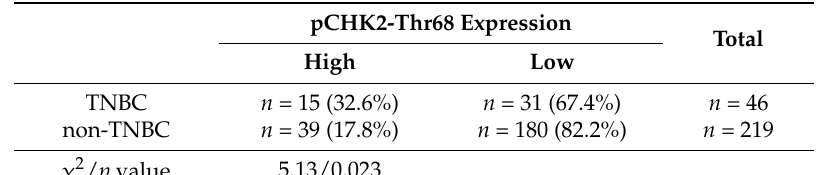
Table 2. Expression of pCHK2-Thr68 in TNBC and non-TNBC tissues.